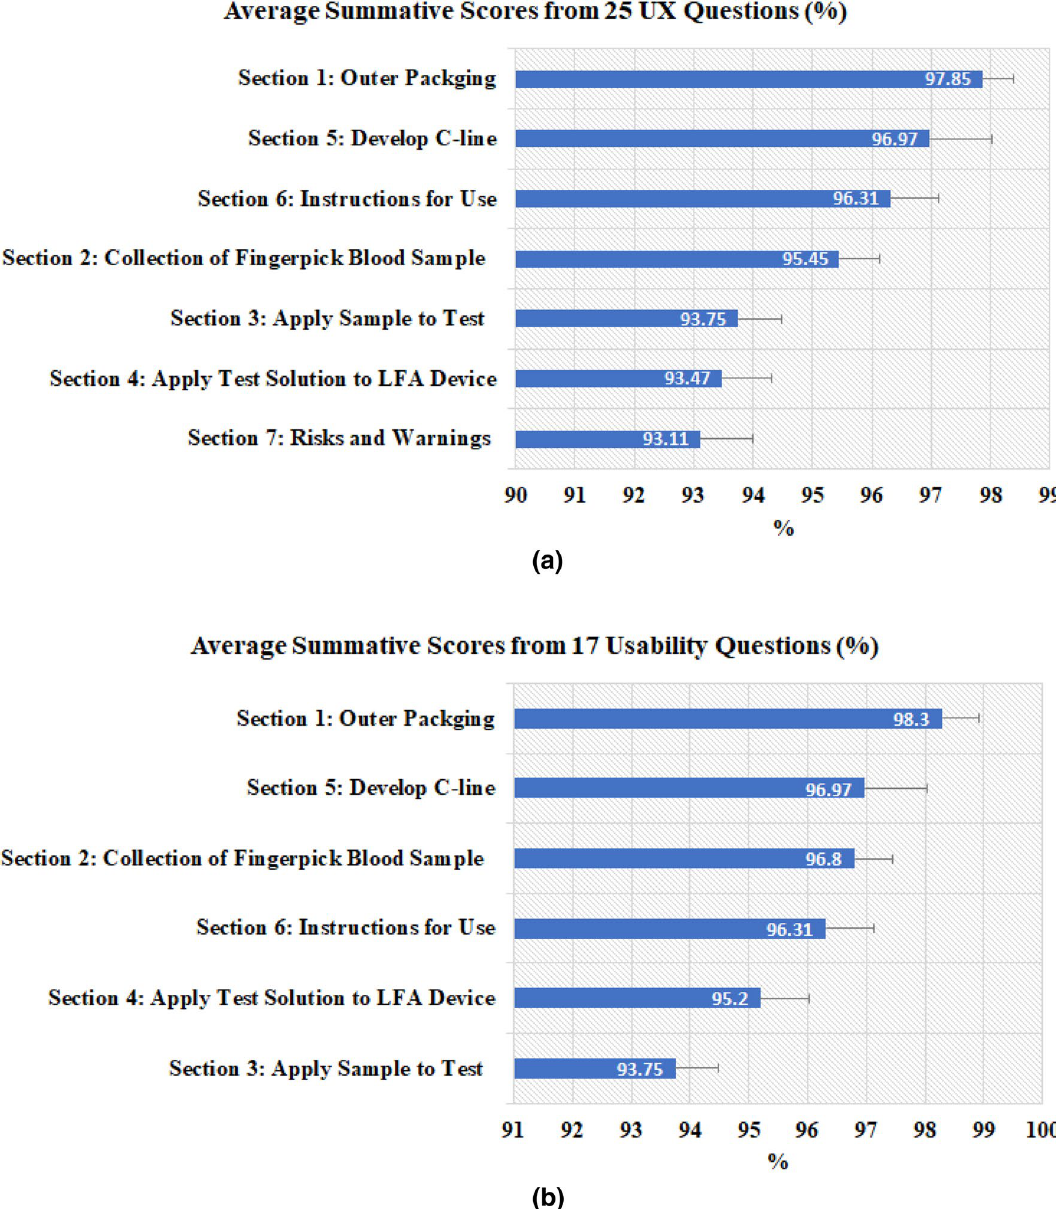
Figure 6. Average summative scores based on: ( a ) 25 UX questions; ( b ) 17 questions related to usability construct only. The error bars represent the standard errors (n =